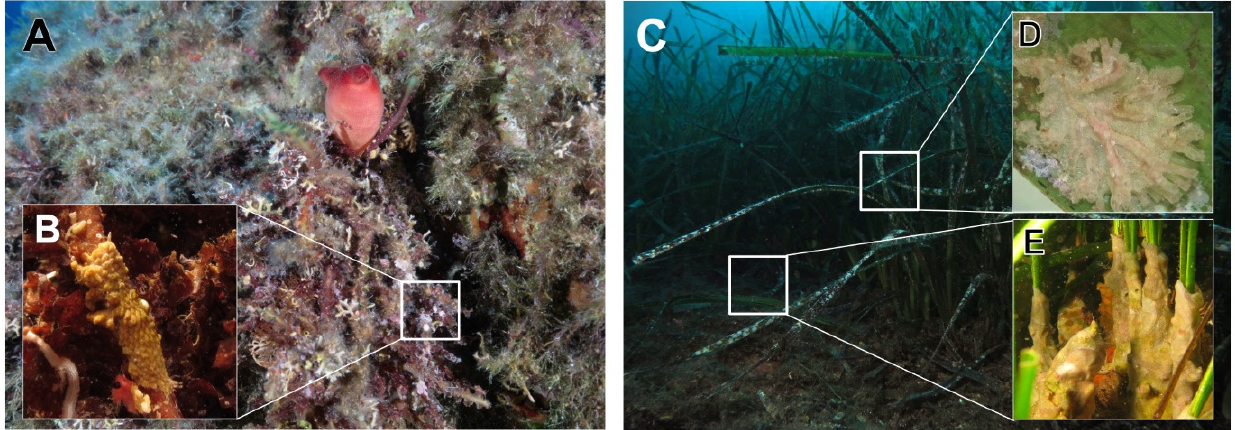
Figure 1. Edge of a Phyllophora crispa mat ( A ) with details on epiphytic fauna ( B ), including bryozoans, serpulids, and foraminiferans. Overview of Posidonia oceanica meadow ( C ), with details on the leaves ( D ) and shoots ( E ). Pictures: E.C. ( A ); F.R. ( B , C , E ); N.S. ( D ).